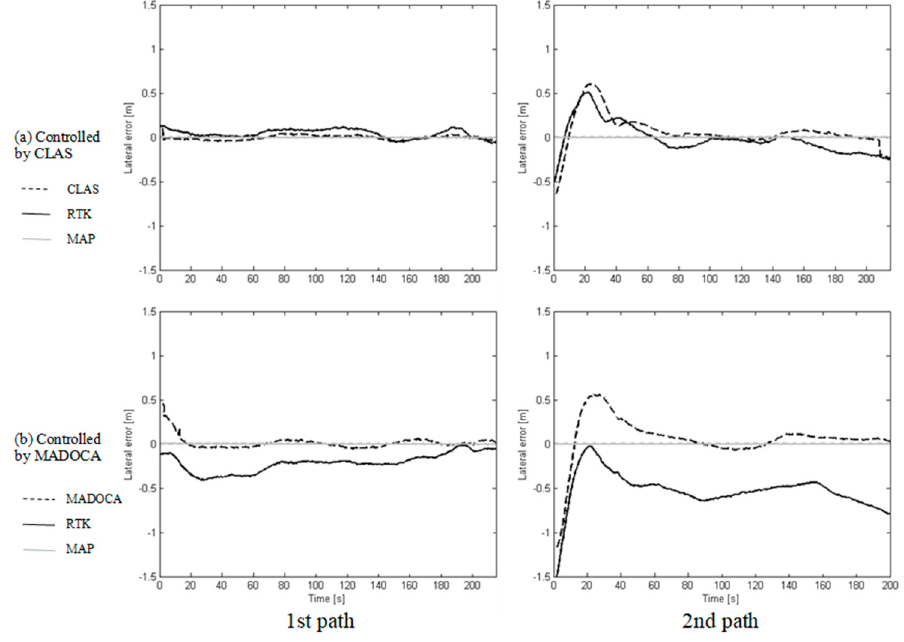
Figure 9. Logged positioning data against time from the first run controlled by ( a ) CLAS ( b ) MA- DOCA.